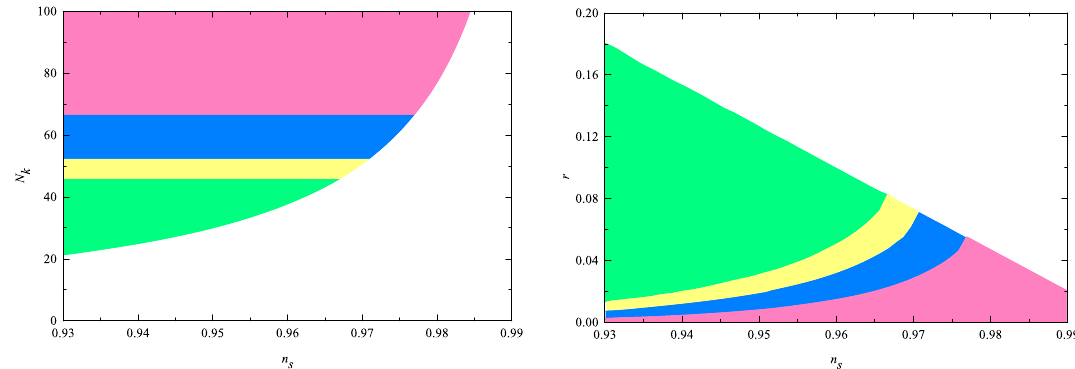
Fig. 4 The N k vs n s and r vs n s under the SNI model, where f m < 30 M p . The green area corresponds to ω re ≤ 0, the yellow area corresponds , the blue area represents the range of 1 to 0 ≤ ω re ≤ 1 5 Table 1 The values of n s , N k and r under the SNI model corresponds to different values of f m and ω re , where T re = 100